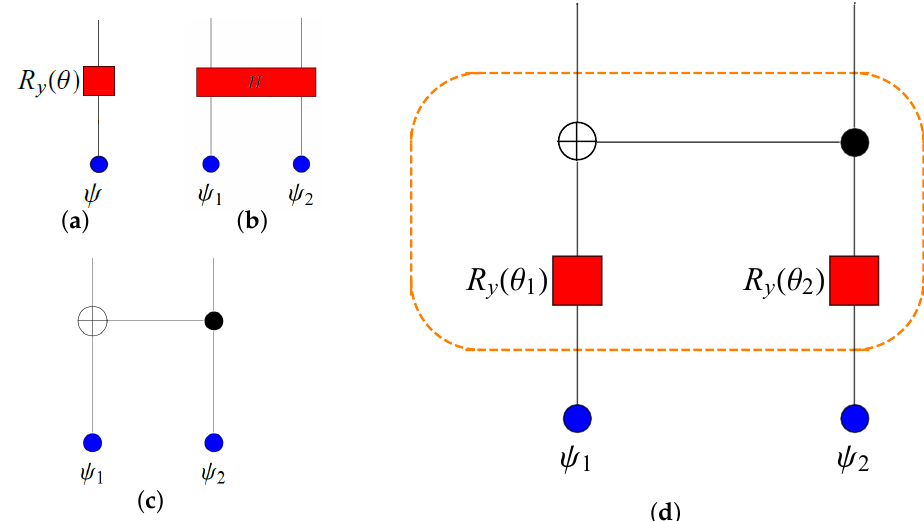
Figure 1. An index contraction is represented in ( a ), which rules a generic nearest-neighbors interaction in ( b ) for a Hilbert space tensor product. In ( c ), the graphical representation of a CNOT gate, which is included in the simple gate of ( d ), encircled by the orange dashed line